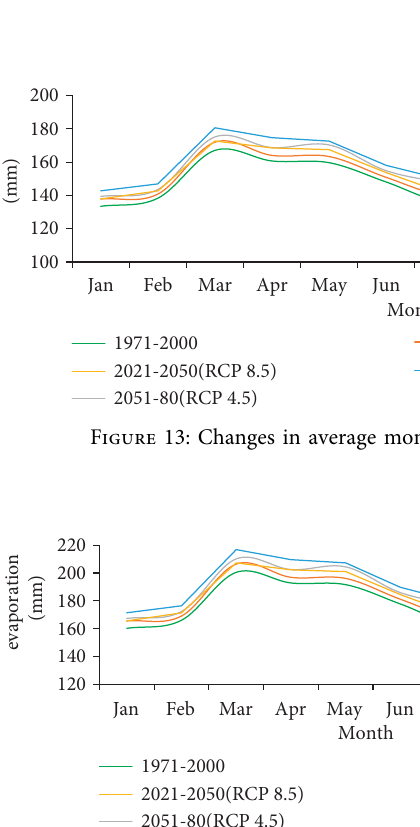
Figure 14: Changes in average monthly evaporation from Kesem reservoir.